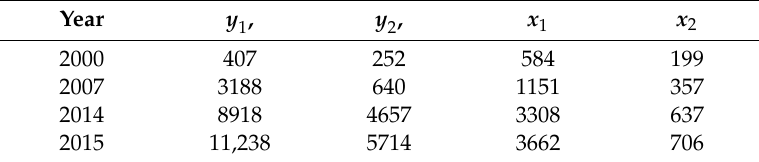
Table 3. Two groups of NF and SI quality parameter data (unit: RMB 100 million).